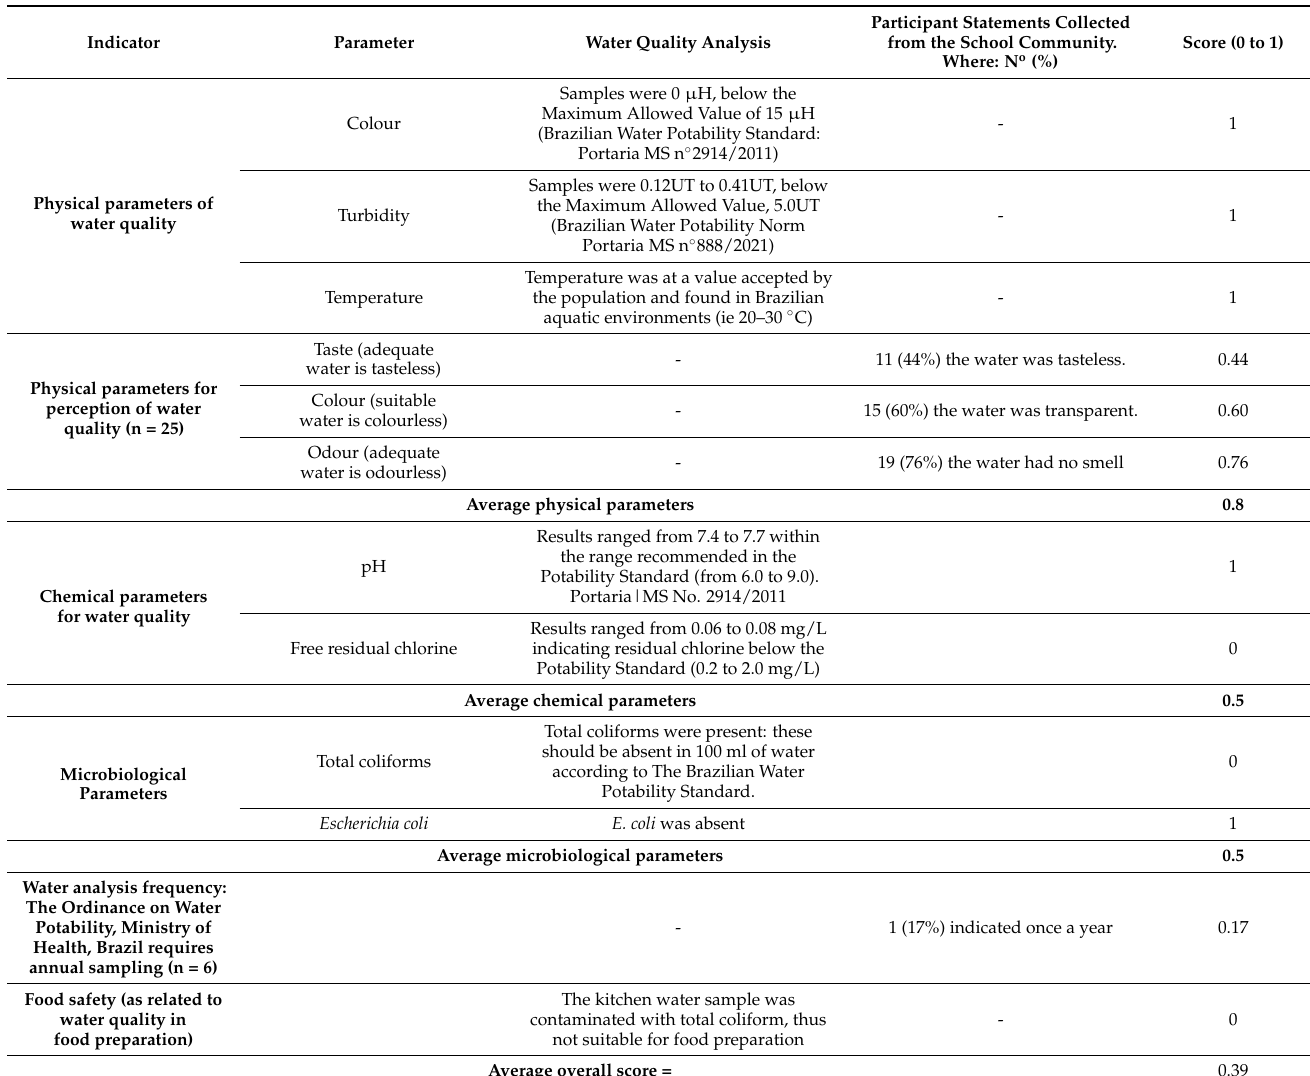
Table 4. Results of the survey carried out for the Sanitary Dimension and its indicators. Weighting was 3; where n = total number of respondents, TU = Turbidity